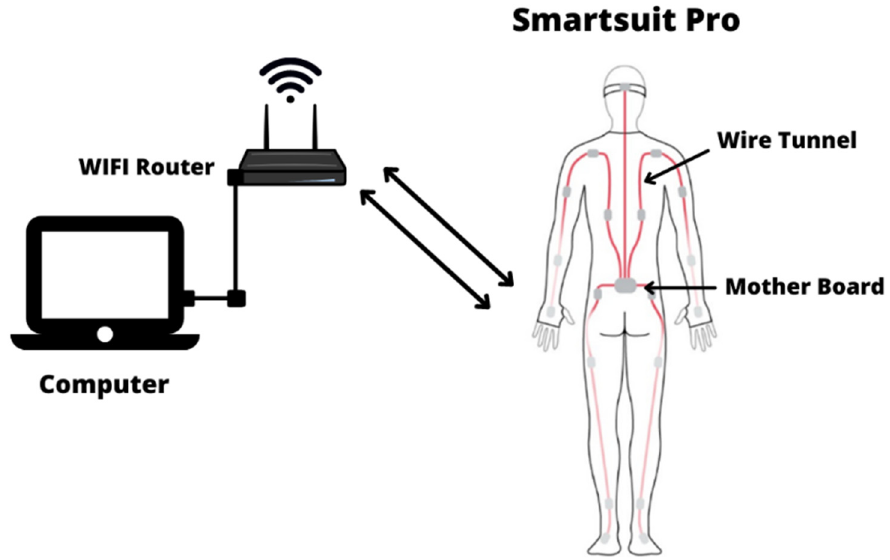
Figure 2. Rokoko Smartsuit Pro sensor placement and hardware setup.